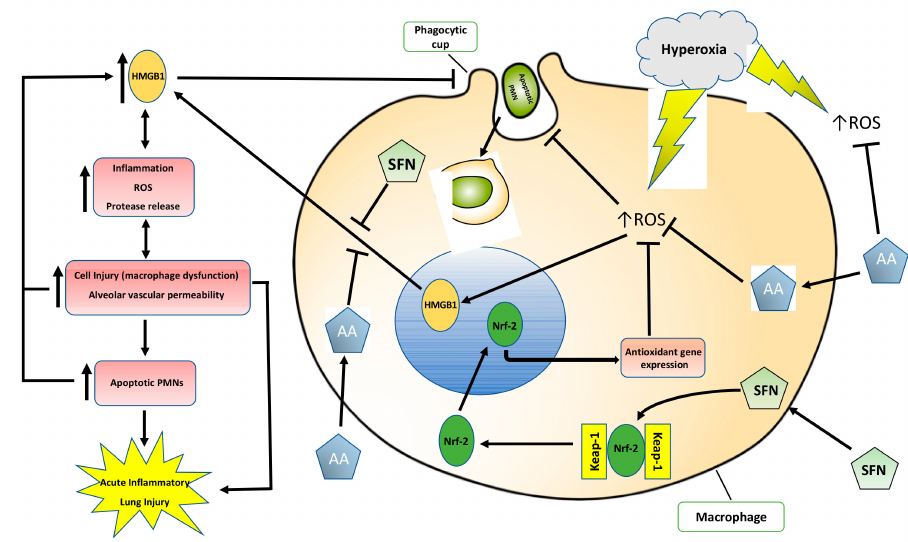
Figure 8. The proposed mechanism by which antioxidants ascorbic acid (AA) and sulforaphane (SFN) attenuate hyperoxia-induced lung injury and compromised macrophage function in phagocytosis. Prolonged exposure to hyperoxia increases the production of intracellular ROS and HMGB1 release, inhibiting lung macrophage phagocytosis and e ff erocytosis, leading to an inflammatory response that produces cell injury. The high levels of airway HMGB1 induce the infiltration of leukocytes into the airways, which further release ROS and HMGB1, contributing to a cycle of dysregulated inflammation, augmenting cell injury and leading to lung damage. Supplementation of AA or SFN significantly reduces ROS and inhibits HMGB1 release, attenuating the cycle of cell injury and ameliorating